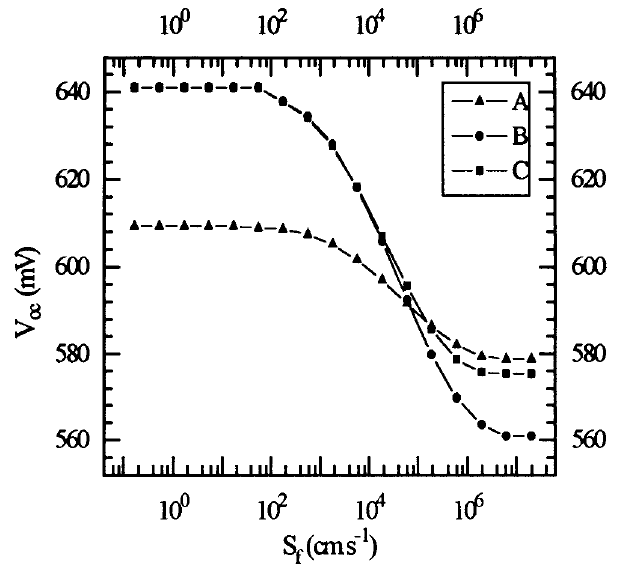
FIGURE 7 Variation of the open circuit voltage V oc according to the surface recombination velocity S f ð S b ¼ 10 15 cm (cid:3) s (cid:2) 1 Þ . For curves (A), (B) and (C), we have: Curve (A): N D ¼ 10 20 cm (cid:2) 3 ; N A ¼ 10 16 : 5 cm (cid:2) 3 ; X ¼ 0 : 1 m m ; H ¼ 295 m m Curve (B): N D ¼ 10 19 cm (cid:2) 3 ; N A ¼ 10 17 : 5 cm (cid:2) 3 ; X ¼ 0 ; 1 m m ; H ¼ 160 m m Curve (C): N D ¼ 10 19 cm (cid:2) 3 ; N A ¼ 10 17 : 5 cm (cid:2) 3 ; X ¼ 0 ; 2 m m ; H ¼ 160 m m.